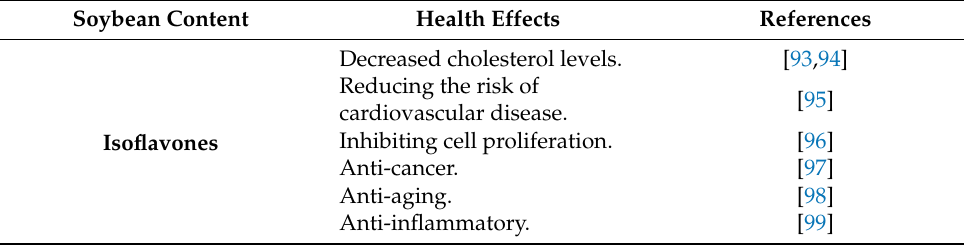
Table 5. Major health effects brought about by isoflavones. Soybean